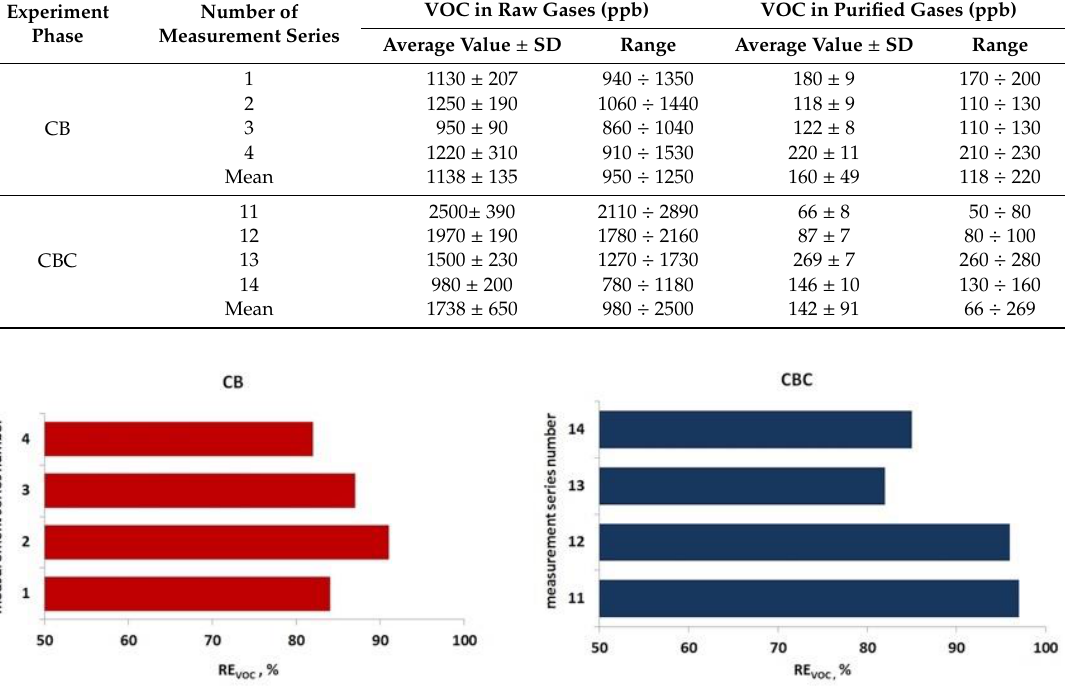
application of two types of fillings–for each measurement series. application of two types of fillings – for each measurement series.